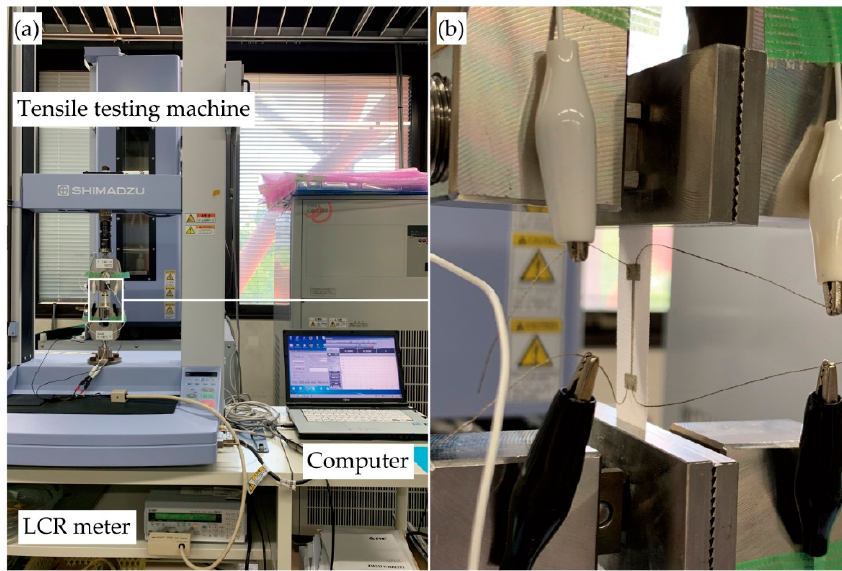
Figure 3 ( a , b ) Setup of resistance measurement under cyclic tensile deformation. Figure 3. ( a , b ) Setup of resistance measurement under cyclic tensile